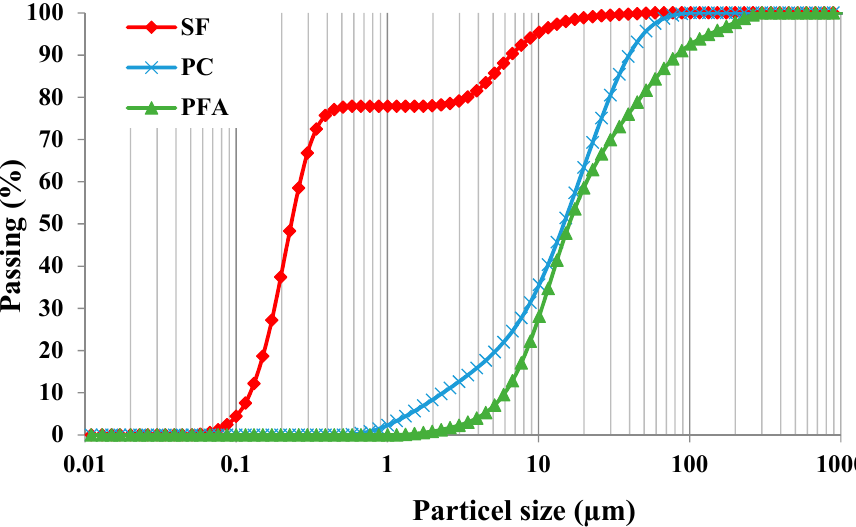
Figure 1. Particle-size distribution analysis of fine powders.